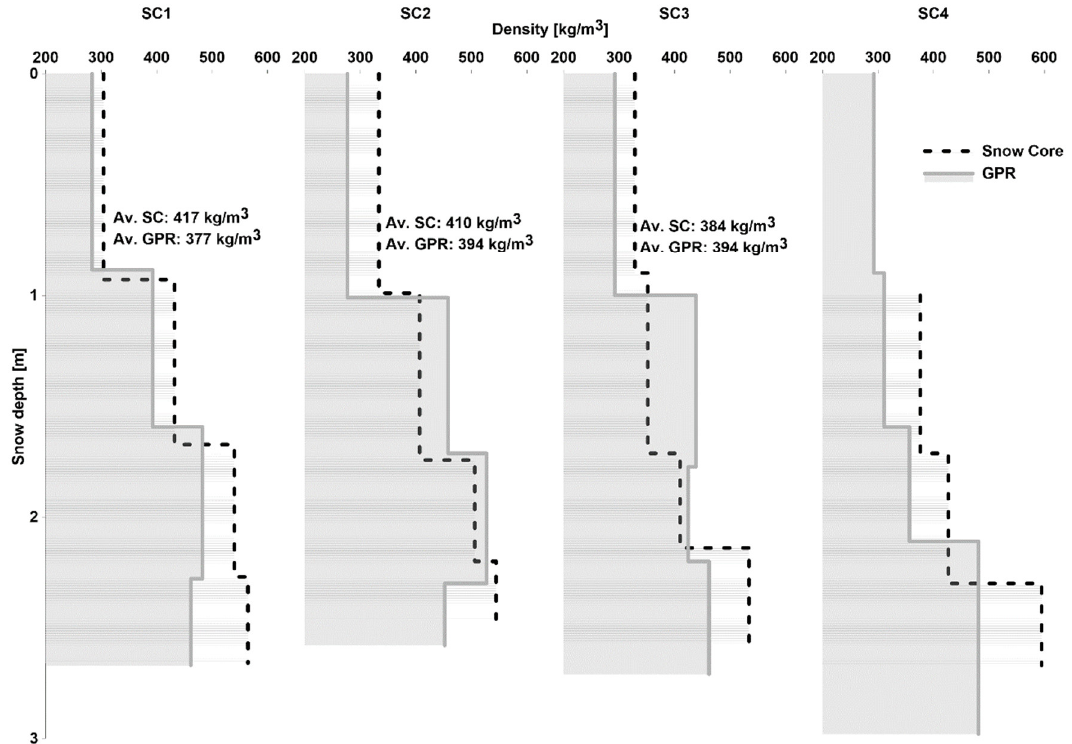
Figure 10. HS and snow density measured in snow cores and derived from the nearest sections of GPR profile. Av. SC—average snow density in the snow core; AV. GPR—average snow density based on density of individual snow layers recognized in the section of GPR profile. Location of the GPR profile and snow cores (SC1, SC2, SC3, SC4) is presented on Figure 1.